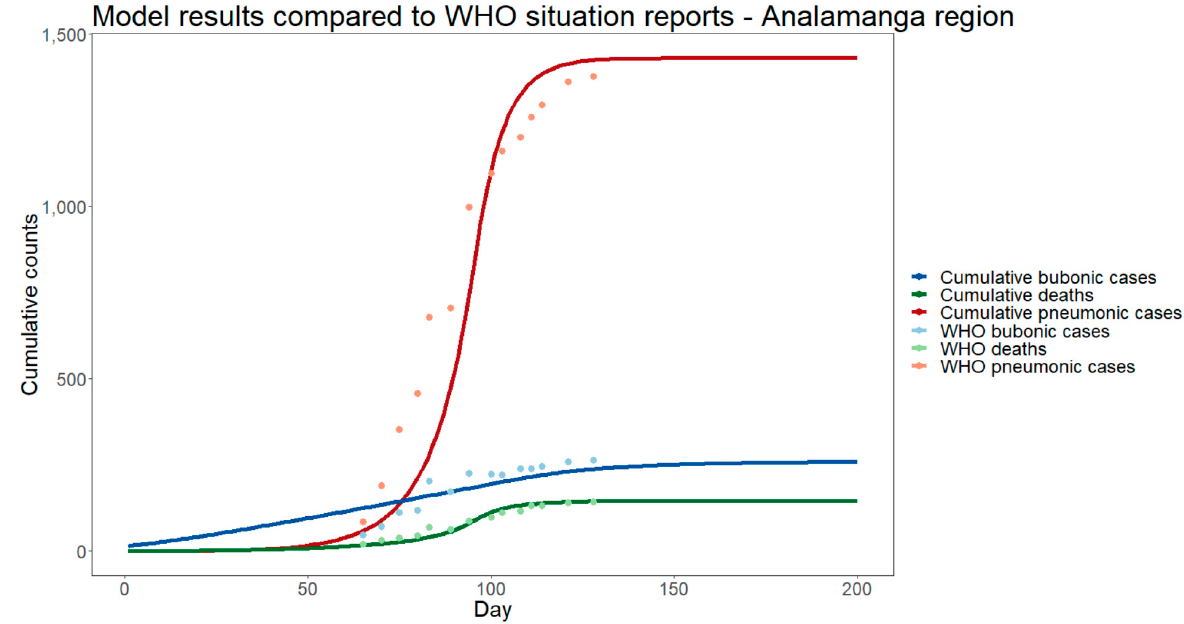
Figure 2. Calibrated model performance on cumulative pneumonic and bubonic plague cases and deaths in the Analamanga region of Madagascar.